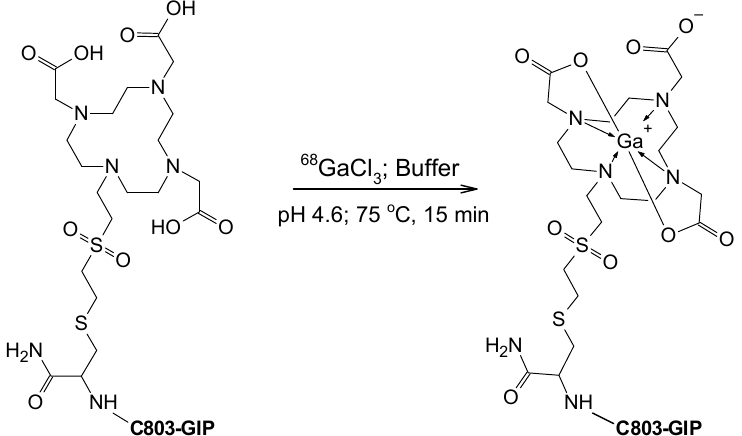
Figure 2. 68 Ga-labeling scheme of C803-GIP, wherein C803-GIP stands for YaEGTFISDYSIALDKI- 2.3. Cellular Internalization and Binding Affinity of [ 68 Ga]Ga-C803-GIP HEK293 cells transfected with human GIPR were subjected to incubation with [ 68 Ga]Ga-C803-GIP for 0, 30, 60, 90, and 120 min. The radioactivity associated with the cells (%ID/million cells) is presented as a function of time in Figure 3. The tracer bound to the cells reached approximately 75% ID/million cells after 60–120 min. The internalized fraction was approximately 40% of the total binding and could be suppressed almost com- pletely by incubation at low temperature (4 °C). The binding of [ 68 Ga]Ga-C803-GIP to huGIPR could be inhibited by 0.3 µM C803-GIP. The binding saturation assay resulted in K d 18.3 ± 6.5 nM and Bmax 2.4 ± 1.0 pmol/Mcells ( n = 3) (Figure 3B). Figure 3. A : Total binding (blue) and internalization (red) of [ 68 Ga]Ga-C803-GIP in HEK293 cells expressing the GIPR presented as a function of time at 37 °C (solid lines) and at 4 °C (dotted lines) for the suppression of internalization. B : GIPR binding saturation was achieved by gradually in- creasing the concentration of [ 68 Ga]Ga-C803-GIP. The total binding (blue), non-specific binding (grey), and specific binding (red, calculated by the subtraction of non-specific binding from the total binding). Data from a representative experiment are shown. 2.4. In Vitro Binding of [ 68 Ga]Ga-C803-GIP to Frozen Sections and Stability in Human Plasma The binding of [ 68 Ga]Ga-C803-GIP to sections of a frozen pellet of cells transfected with the GIPR was strong and could be abolished by co-incubation with 10 µM GIP(1-42)